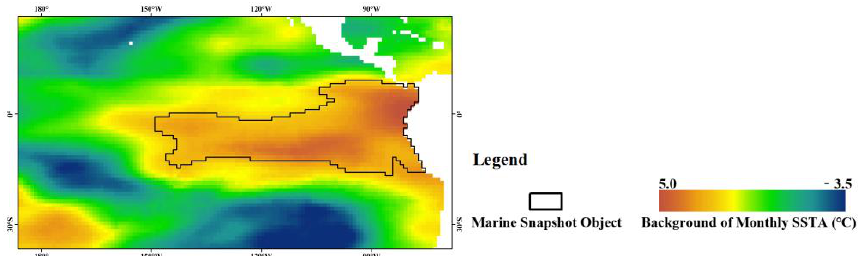
Figure 13. Linked object in June 1997, in which sequence object 1 and object 2 merge into sequence object 3 in the Equatorial Eastern Pacific Ocean. The background is the monthly SSTA.